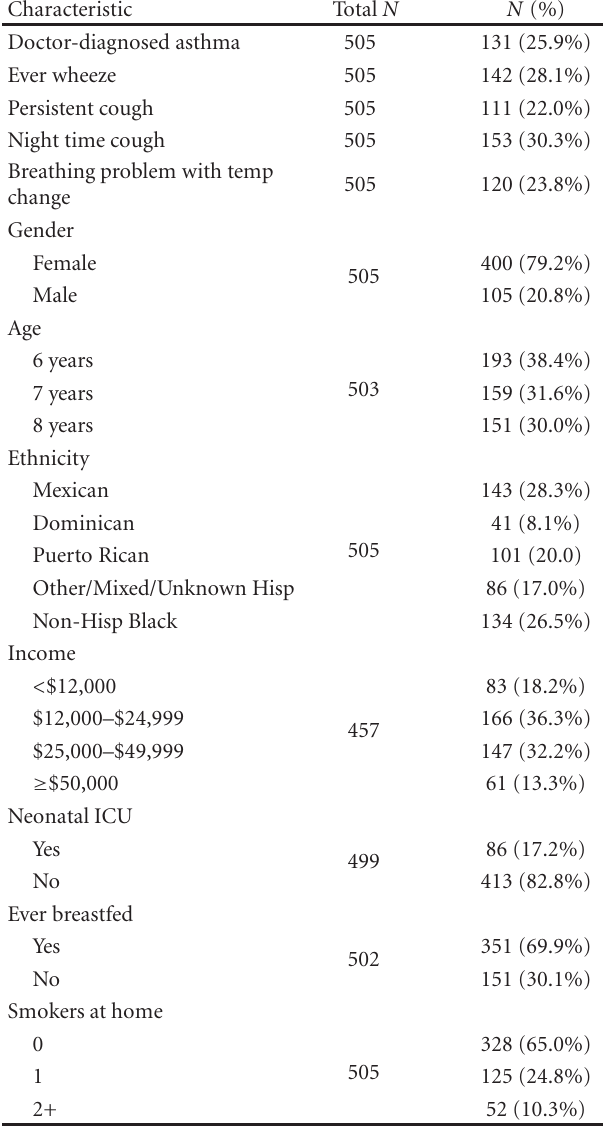
Table 1: Descriptive characteristics New York City children